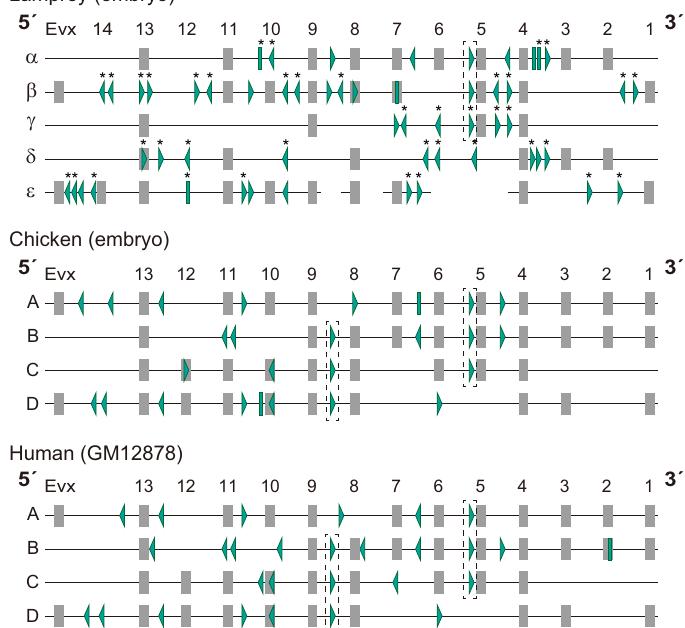
Figure 4. Distribution of CTCF binding sites in Hox clusters. Coding region of genes are indicated with gray boxes. CTCF binding sites are indicated with green arrowheads and bars. Arrowheads indicate the orientations of core motifs inferred by the FIMO program. Green bars indicate CTCF binding sites without a core motif. CTCF binding sites of the Arctic lamprey that overlap repeats are indicated with asterisks (see Results for details). Arrowheads in dashed boxes represent shared relative positions of CTCF binding sites between multiple Hox clusters. This figure includes only “significant peaks” defined in Materials and Methods. See Supplementary Fig. S6 for an equivalent scheme in mouse, dog, and opossum, and Supplementary Fig. S7 for detailed locations of all the peaks in Hox clusters. For the Arctic lamprey, we analyzed only Hox α - ε clusters that were identified in continuous sequences harboring multiple Hox